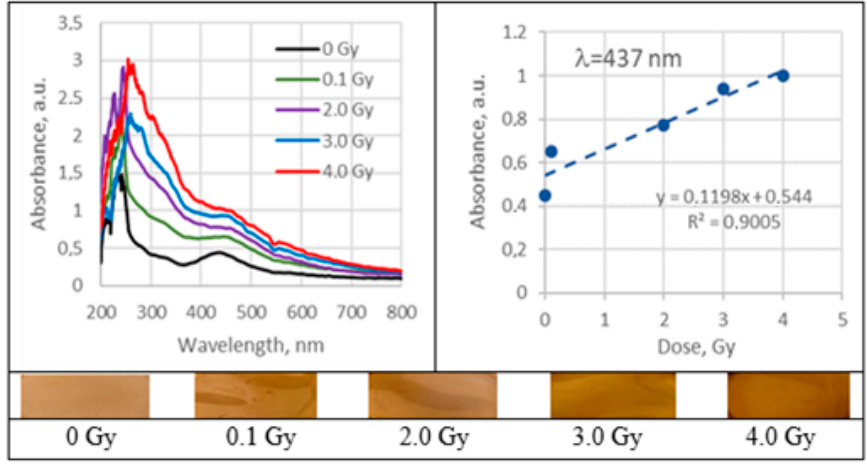
Figure 13. Absorbance and sensitivity of 6 MeV irradiated 1AgEthaPVA films.3. Discussions.